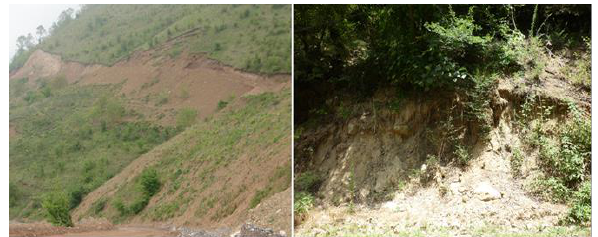
Figure 2. Photos of Landslide in Study area